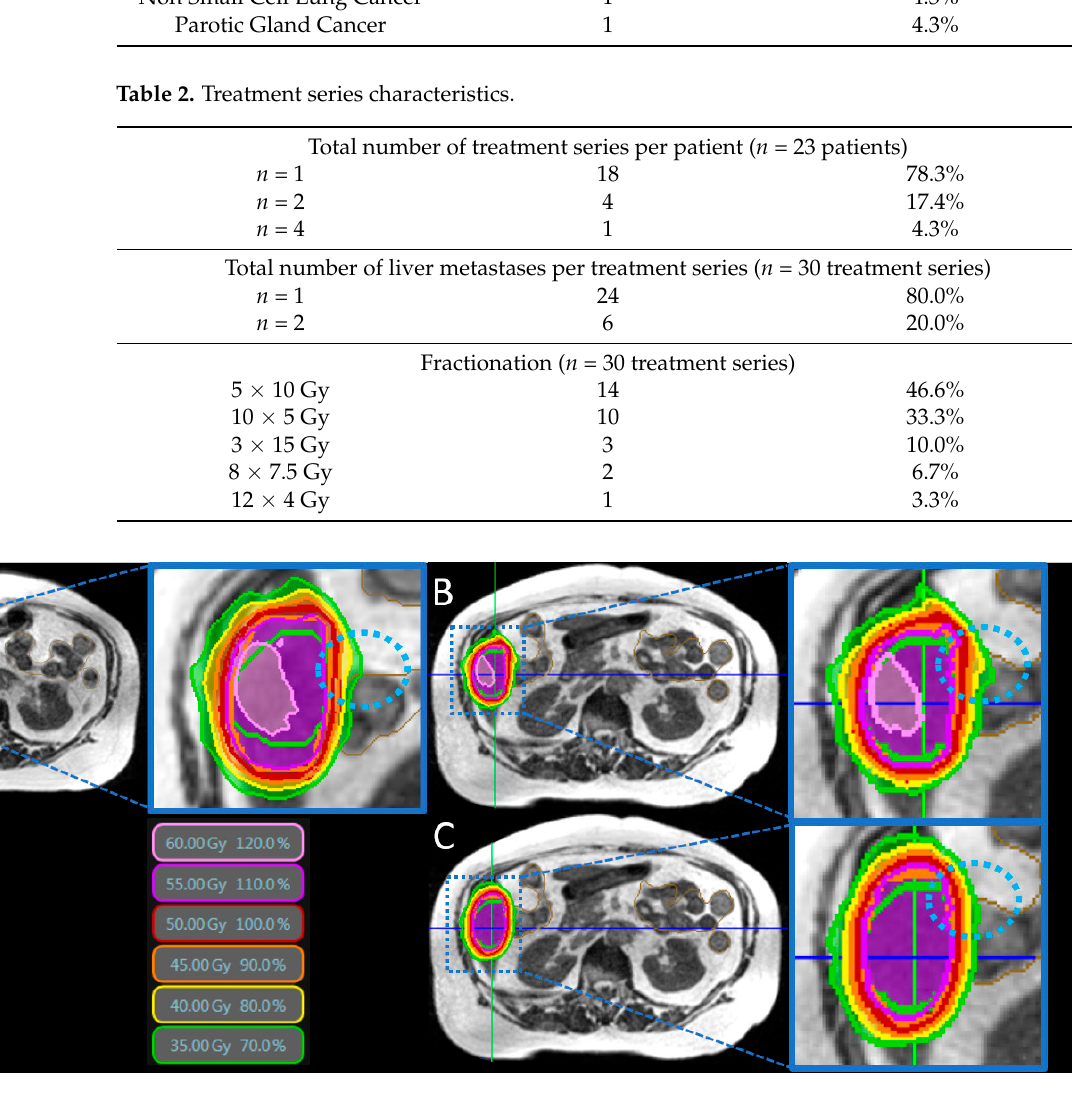
significantly decreased with plan adaptation (Figure